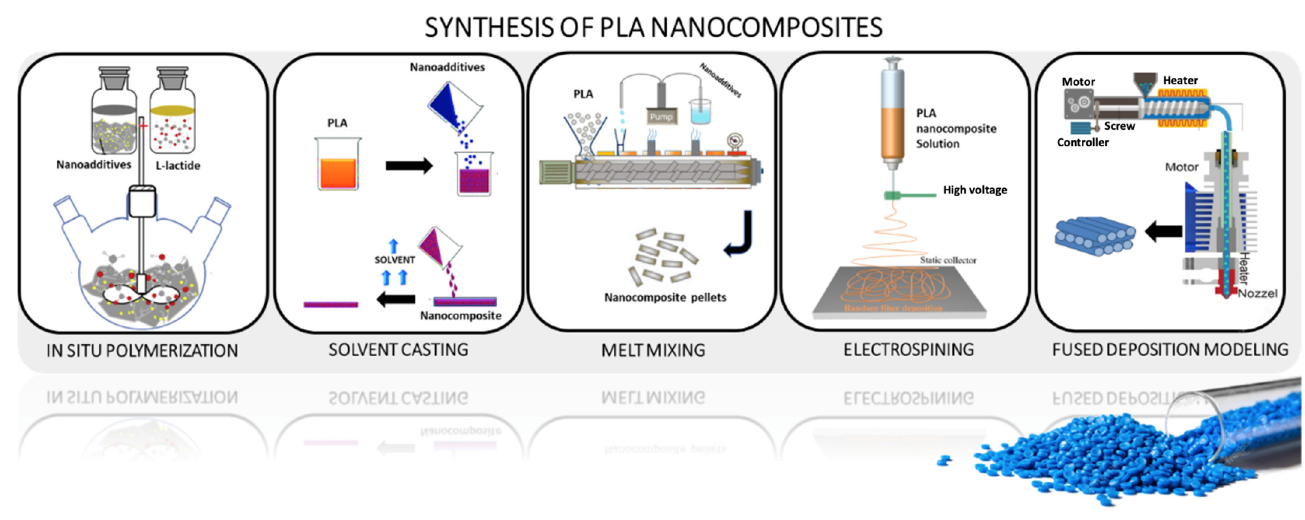
Figure 1. Synthetic routes employed for the preparation of PLA nanocomposites.